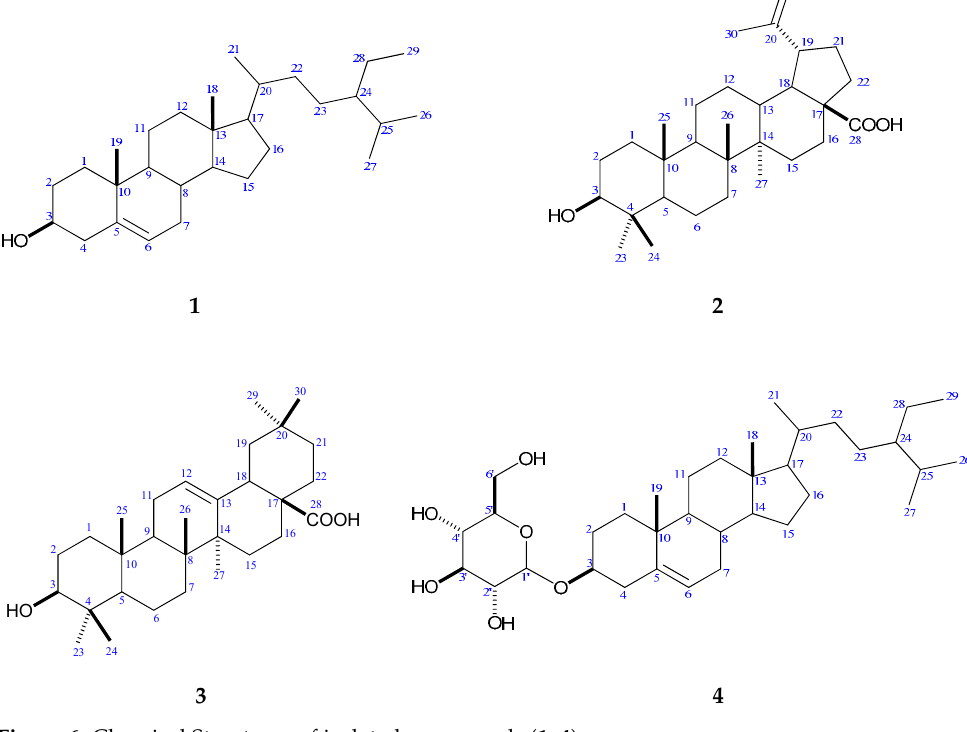
Figure 6. Chemical Structures of isolated compounds ( 1 – 4 ).